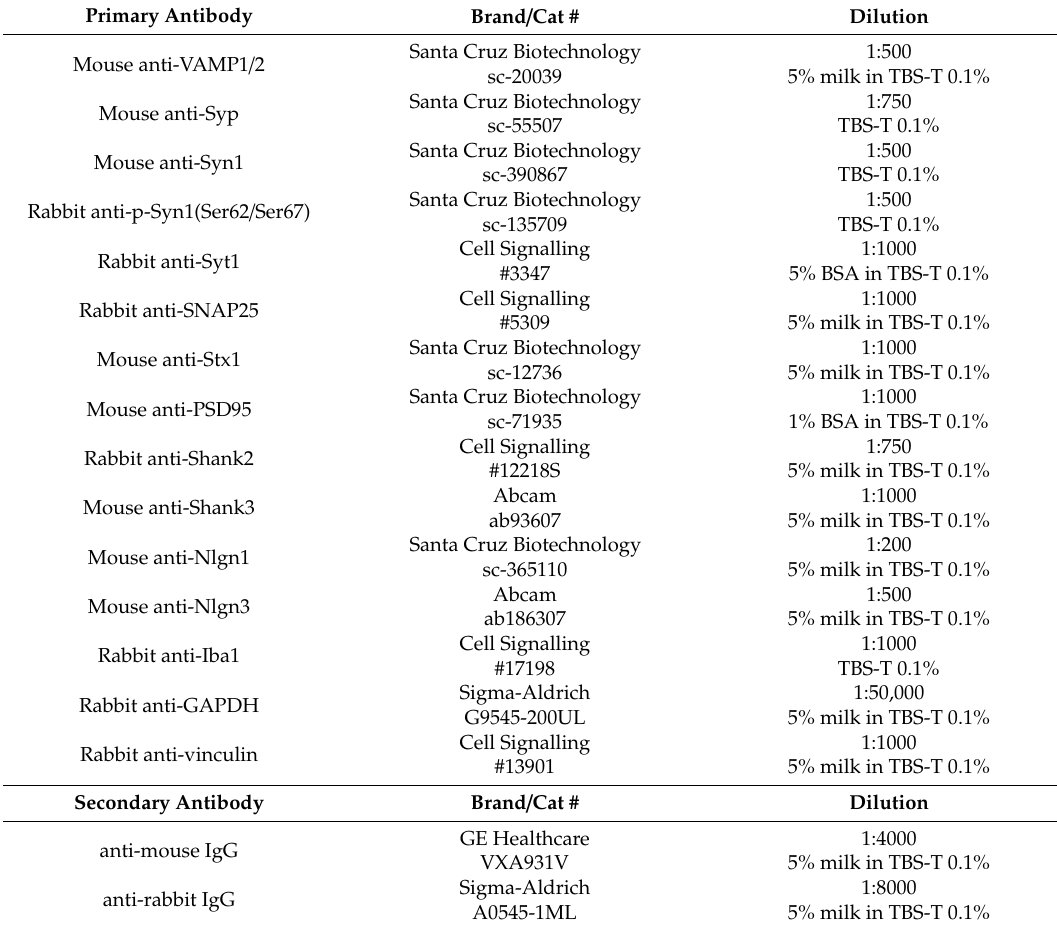
Table 1. Conditions used to perform the Western blot